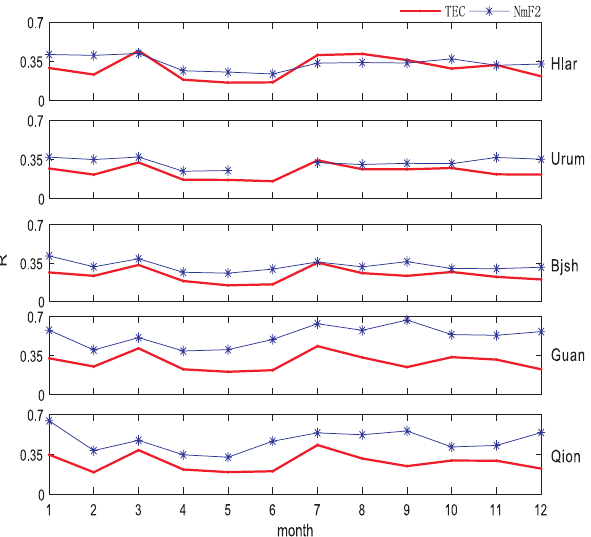
Fig. 9. Relative ranges of day-to-day variations with month for both TEC and Nm F2. Table 3. The mean value of U , L , R and K of Nm F2 in 2004. Hlar Bjsh Urum Guan Qion